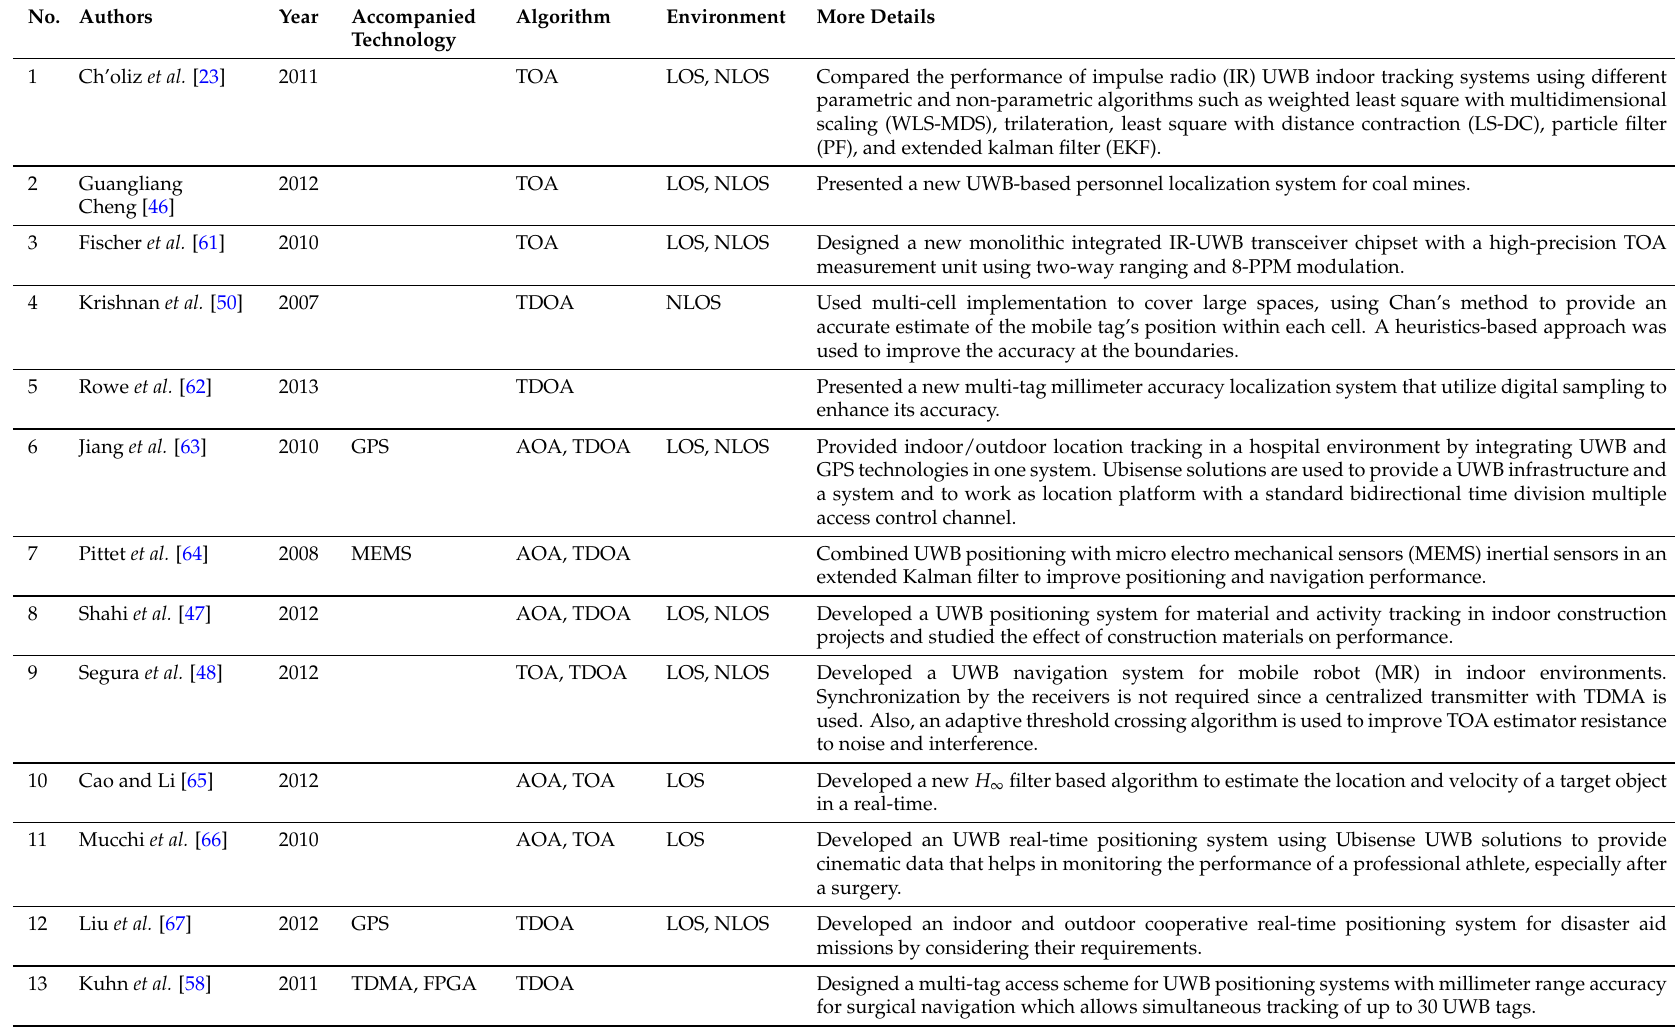
Table 7. Comparison of Ultra WideBand (UWB)